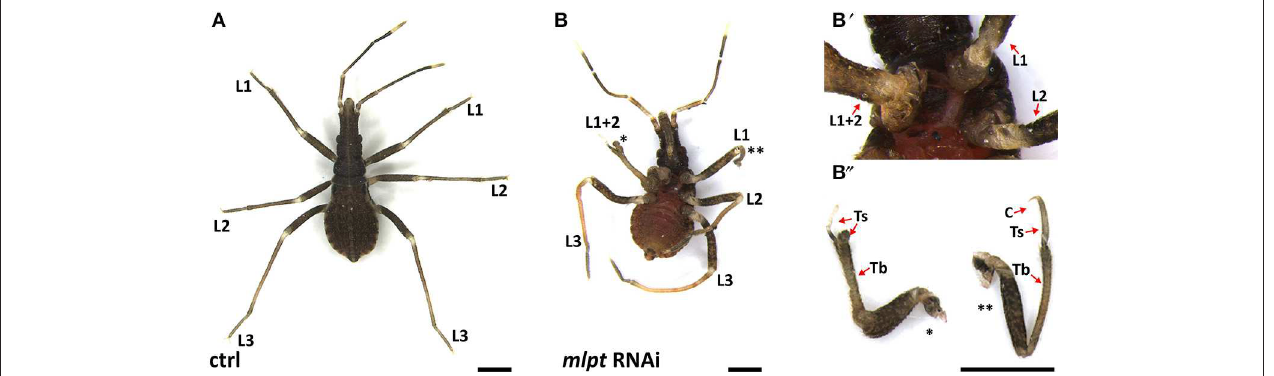
FIGURE 6 | Segmental fusion and leg defects after mlpt RNAi. (A,B) Control (A) and mlpt RNAi nymph (B,B ′ ,B ′′ ) . (B’) mlpt RNAi nymph showing unilateral leg fusion of L1 and L2. (B ′ ,B ′′ ) Higher magnification of distal regions of fused legs show morphologies that deviate from the wild-type pattern. Several phenotypic changes from the wild-type pattern are observed after mlpt RNAi such as lack of distal regions such as tarsus (Ts) and claws as highlighted in (B ′′ ) . Tb, tibia; Ts, tarsus; C, claws. Scale bar 500 µ